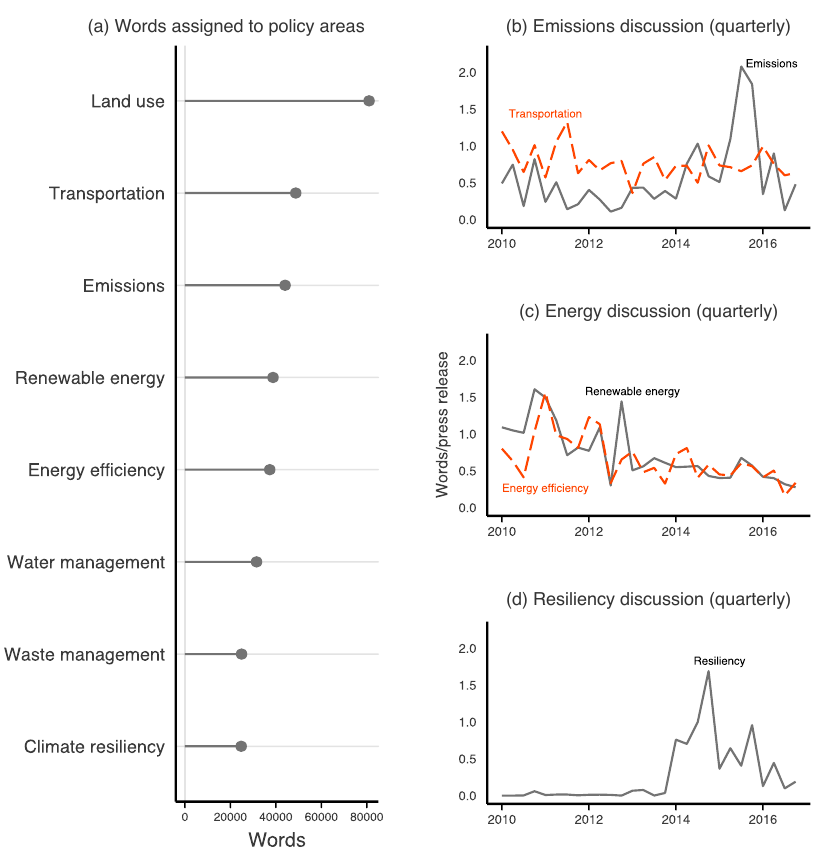
Figure 2. Discussion of key policy areas. ( a ) Provides the total number of words assigned to each of the main “seeded” topics using the model described in Section 2.2. ( b – d ) Quarterly discussion of Emissions and Transportation, Energy efficiency and Renewable energy, and Climate resiliency, respectively. Word totals are normalized by the number of press releases in each